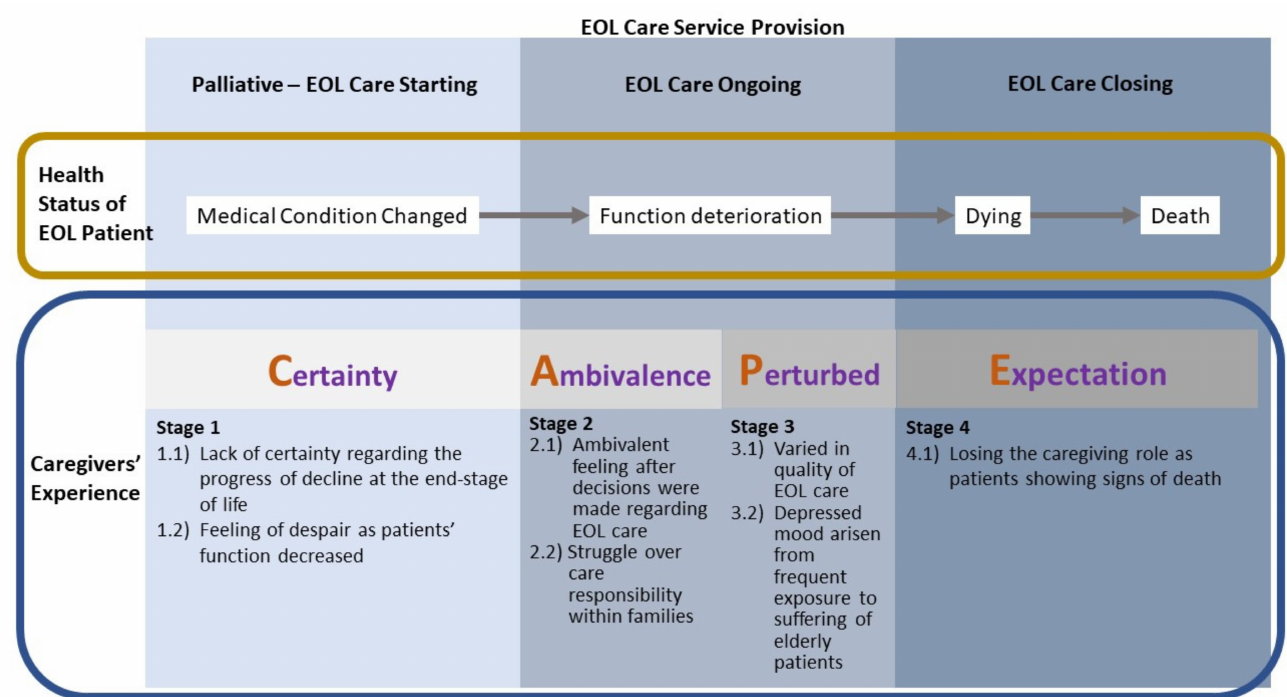
Figure 1. Thematic map of four stages “CAPE” reflecting caregivers’ challenges along EOL